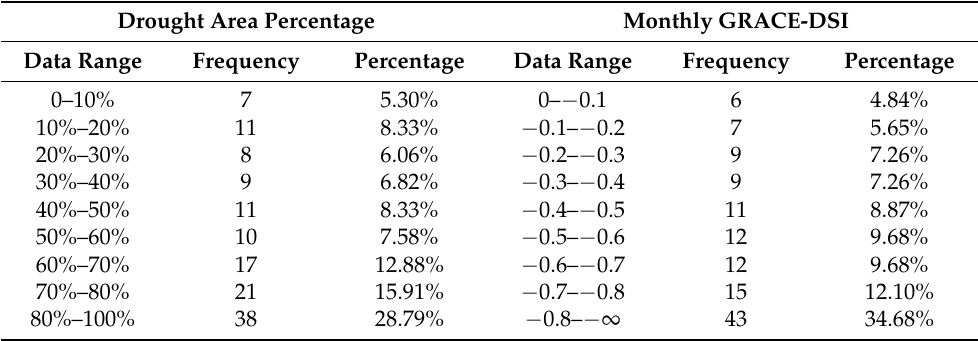
Table 5. Frequency table of the drought area percentage and monthly GRACE-DSI in four study regions.